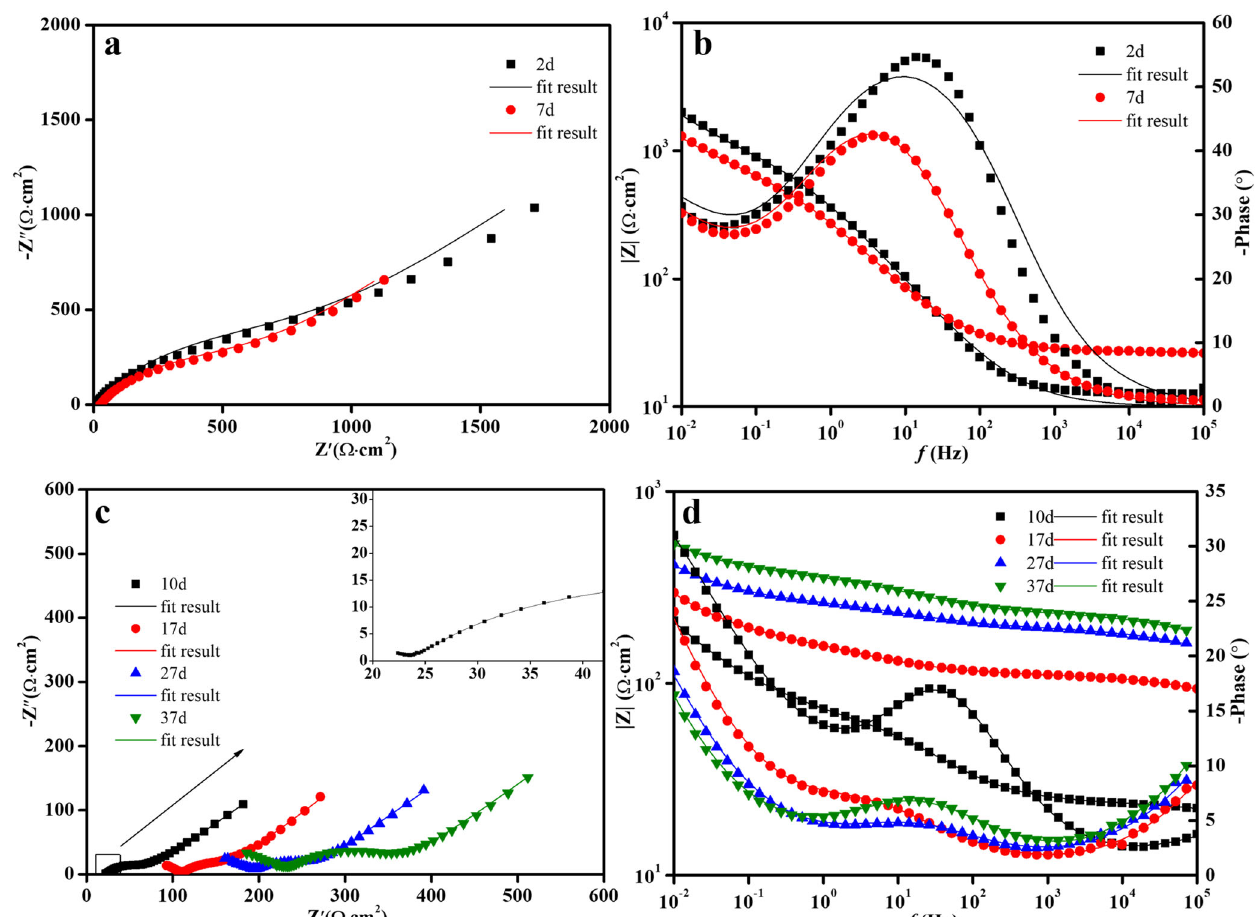
Fig. 7 EIS. Electrochemical impedance spectra of 9-1# (the fi rst electrode in row 9 in the mid-tide zone) with respect to time: a , c Nyquist plots and b , d Bode